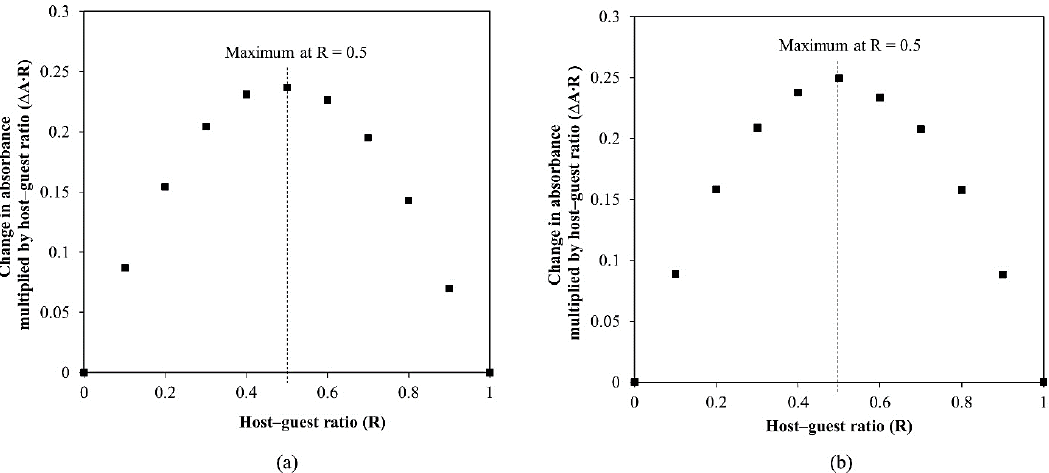
Figure 4. Continuous variation plot (Job’s plot) of ( a ) the nicotine/ β CD inclusion complex and ( b ) nicotine/M β CD inclusion complex.